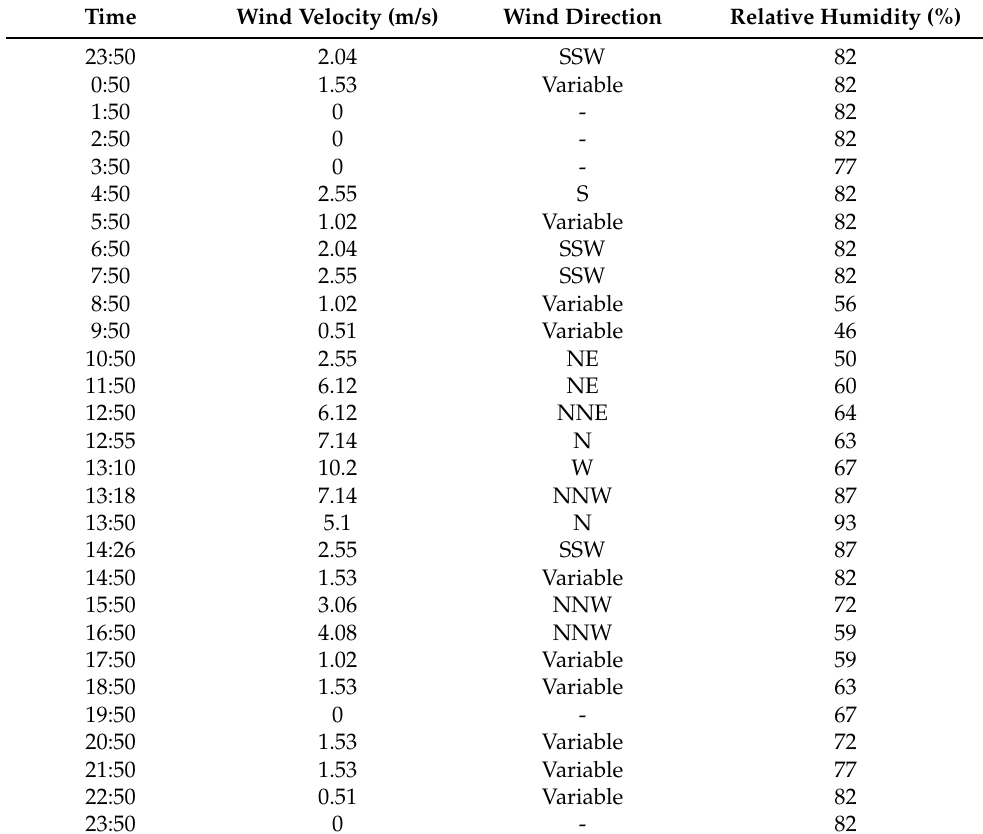
Table A1. Meteorological data for Pescara, 10